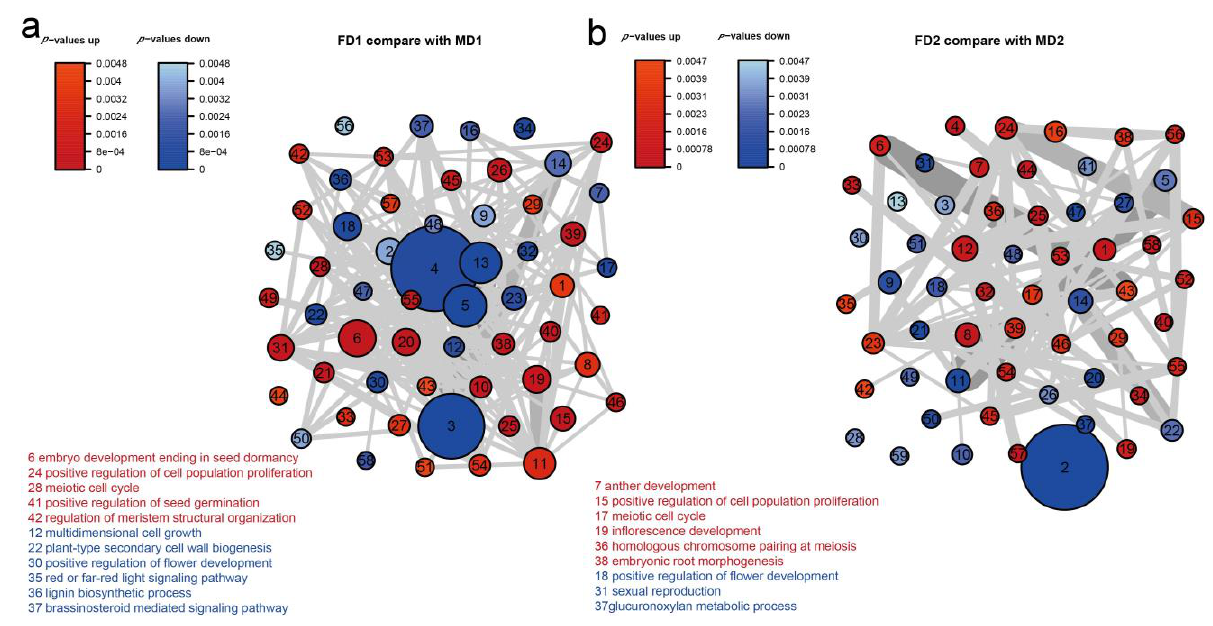
Figure 4. Gene set analysis of biological function changes during the development of female and male flower buds. ( a ) The initial differentiation stage of flower buds and ( b ) the flower primordial development formation stage. Biological function GO terms of differentially expressed genes of the early and second stages were subjected to analysis using R package PIANO [39]. The distinct directional network plot was drawn with a gene set significance threshold of p < 0.005. Each node’s size represents the node’s number of genes, and the width of the edges connecting nodes indicates the number of shared genes between nodes. The blue and red nodes represent the GO terms of differential genes of male and female flower buds.